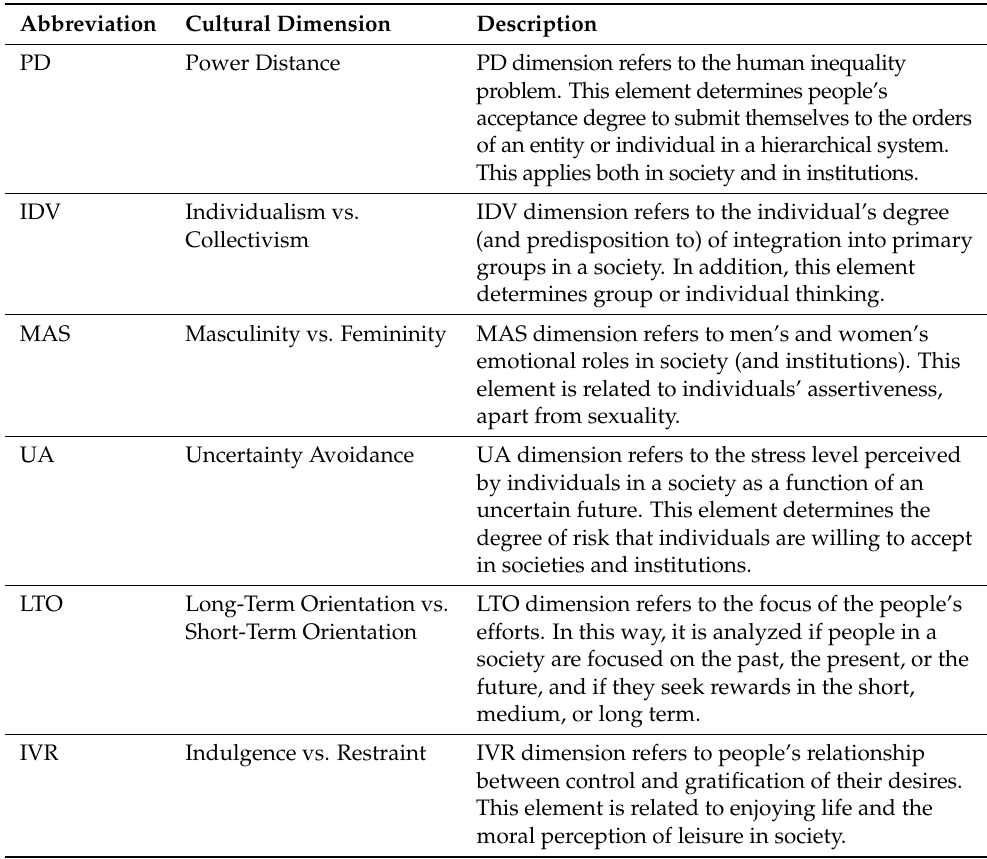
Table 1. Hofstede’s national culture